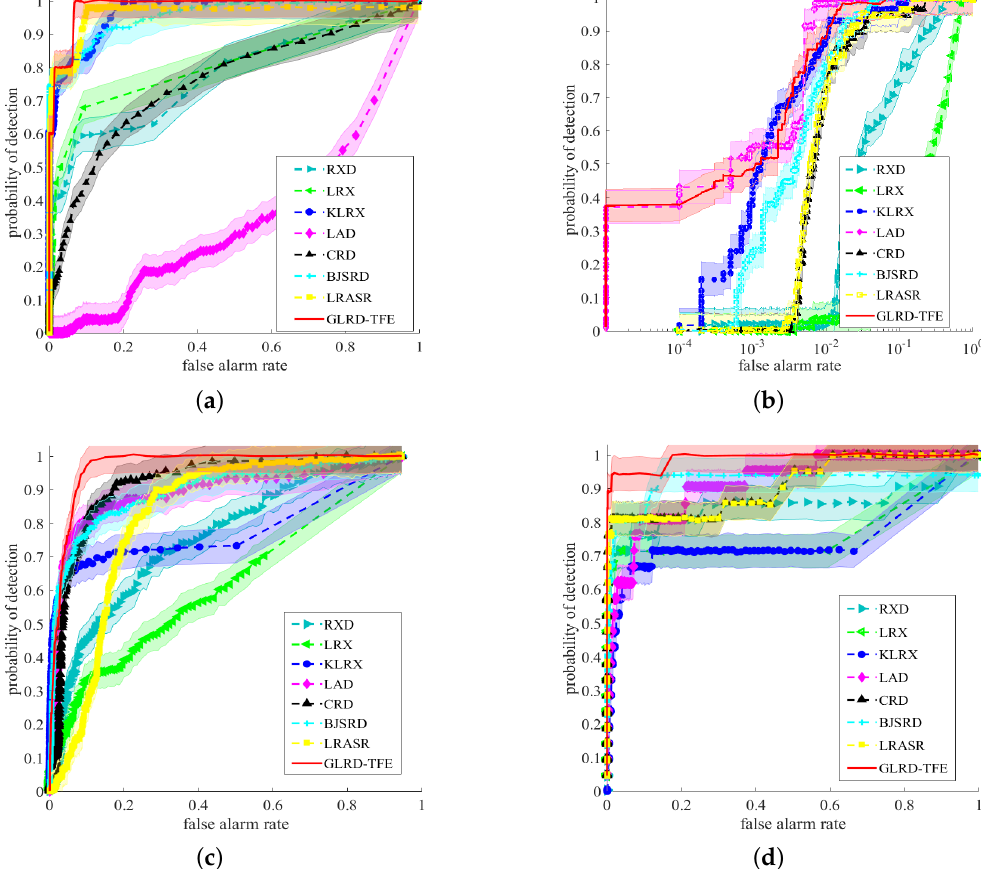
Figure 12. ROC curves of the comparison methods on four different datasets. ( a ) Simulated dataset; ( b ) AVIRIS–I dataset; ( c ) AVIRIS–II dataset; ( d ) HYDICE